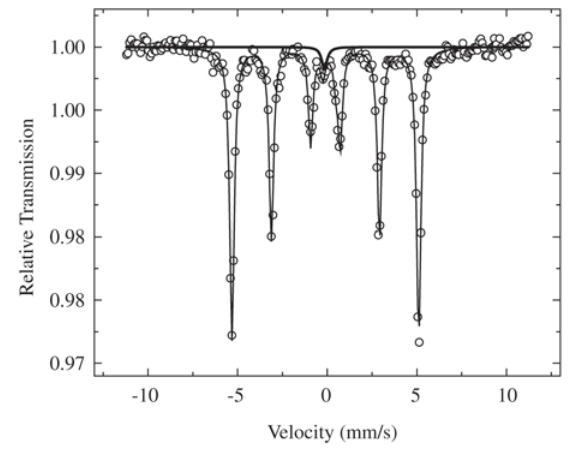
Figure 4. Mössbauer spectrum of the Fe room temperature, showing singlet and sextet subspectra derived from an overall